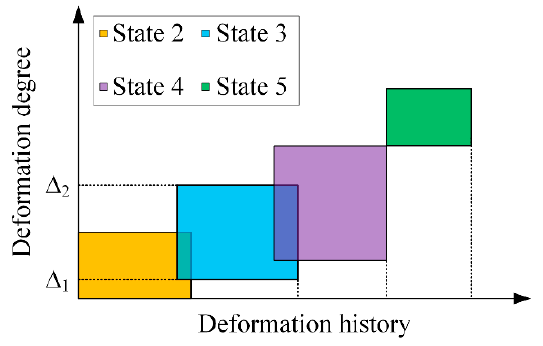
Figure 3. Sequence diagram of the five states during the roller swaging process.